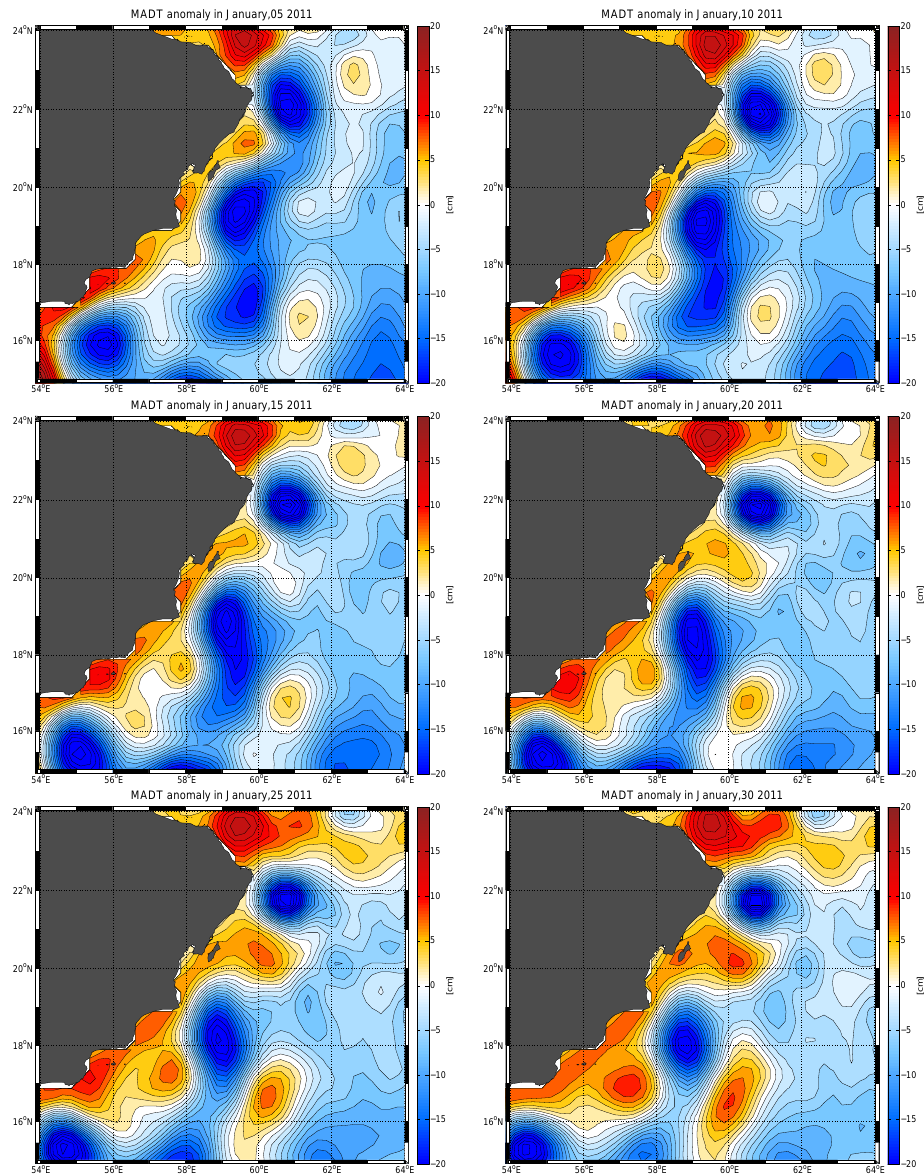
Figure 7. Maps of the MADT anomaly from AVISO, during the winter monsoon, in January 2011, every 5 days. The first map shows the presence of meanders on the coastal current, then forming coherent mesoscale eddies at 18 ◦ N, 58 ◦ E on 20 January and at 18 ◦ N, 58 ◦ E on 30